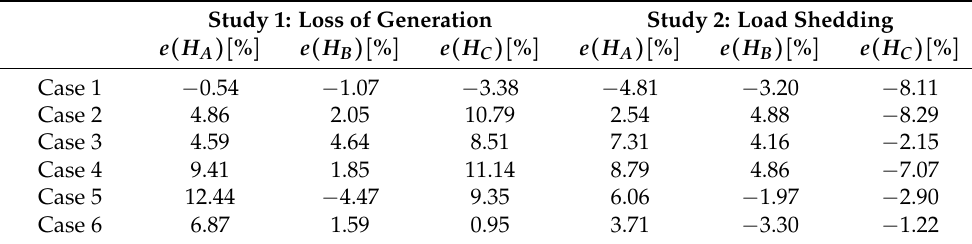
Table 2. Representative inertia estimation results. Study 1: Loss of Generation Study 2: Load